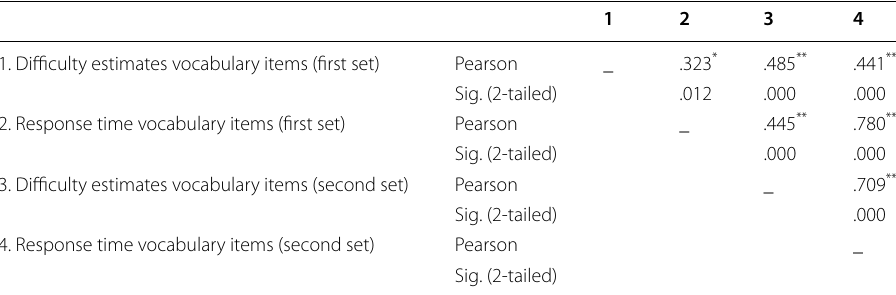
Table 4 Pearson’s product moment correlation of response time and difficulty estimates (vocabulary